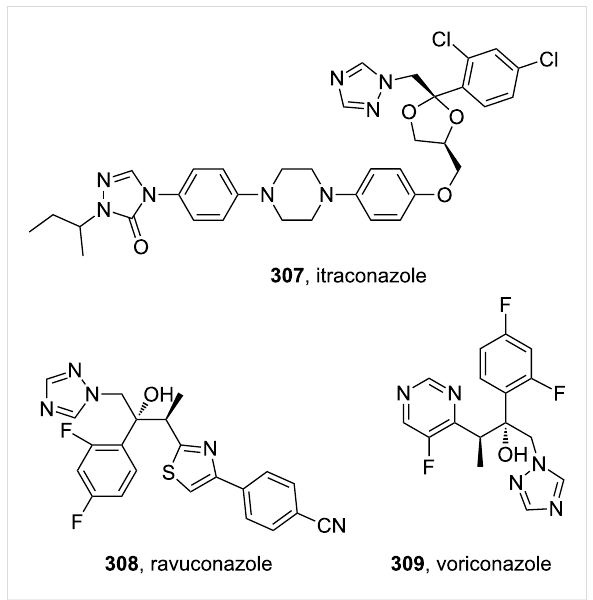
Figure 9: Structures of itraconazole, ravuconazole and